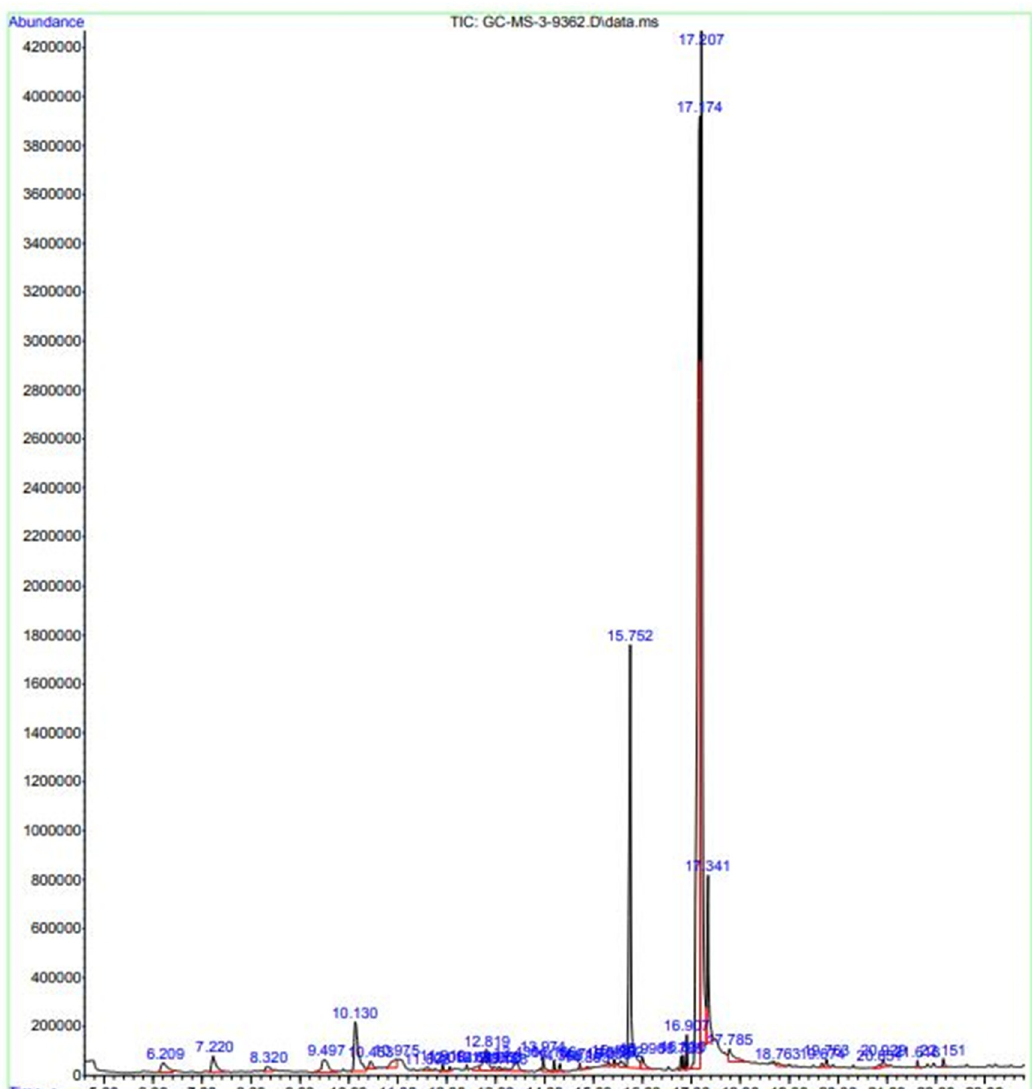
Figure 1: GC - MS spectrum of E. hirta ethanolic